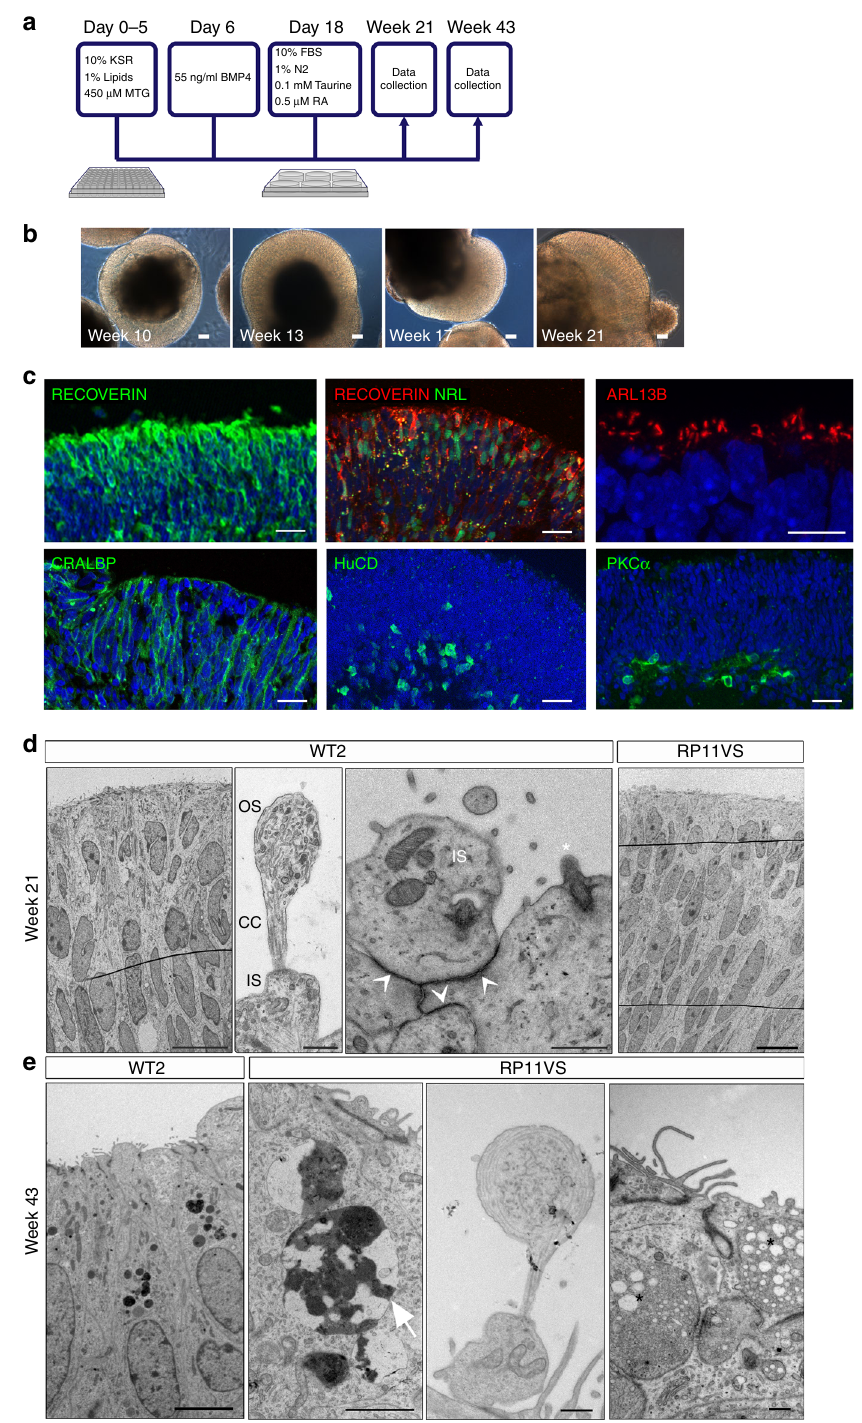
Fig. 2 Generation of retinal organoids following long-term suspension culture. a Schematic representation of iPSC differentiation to retinal organoids; b Bright- fi eld images showing development of retinal neuroepithelium over time, scale bar 50 μ m; c Immunostaining of retinal organoids showing the expression of cell-speci fi c markers; b – c representative examples from iPSC-derived retinal organoids from RP11S2 patient are shown, scale bar 25 μ m apart from ARL13B, where scale bar is 10 μ m; d TEM revealed the presence of outer limiting-like membrane (white arrows), inner segments (IS), connecting cilia (CC) and developing outer segments (OS) in retinal organoids after 21 weeks in culture, top panel scale bars: 10 μ m, 500 nm, 500 nm, 10 μ m, bottom panel scale bars: 5 μ m, 2 μ m, 500 nm, 500 nm; e At 43 weeks in culture, TEM showed that patient photoreceptors contained apoptotic nuclei with electron dense structures of condensed chromatin (white arrow) and stress vacuoles (black stars). d , e Representative examples of three independent